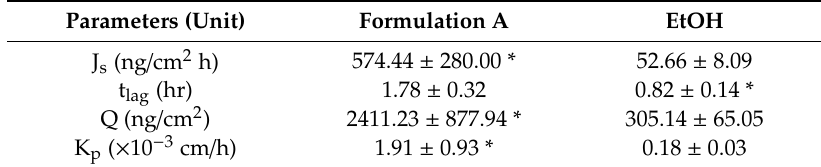
Table 2. Penetration parameters of Sal. B in di ff erent vehicles through normal murine skin after 6 h (mean ± SD, n = 3).